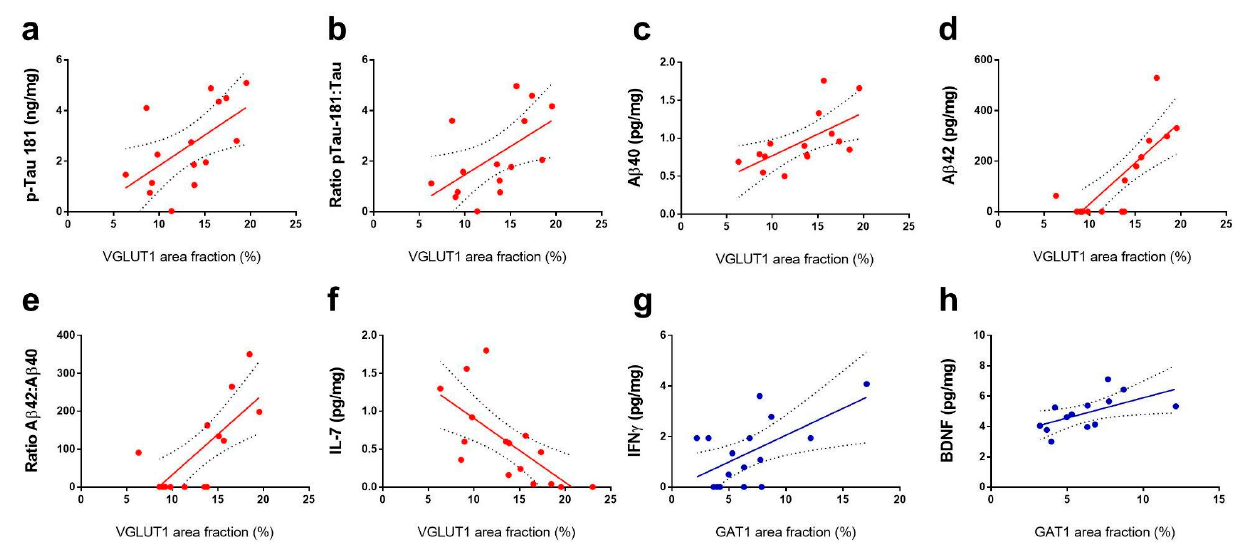
Figure 7. Significant correlations between VGLUT1 (red, ( a – f )) and GAT1 (blue, ( g , h )) area fractions and Luminex protein concentrations. Regression lines with 95% confidence intervals are shown when a significant ( p < 0.05) relationship is observed.